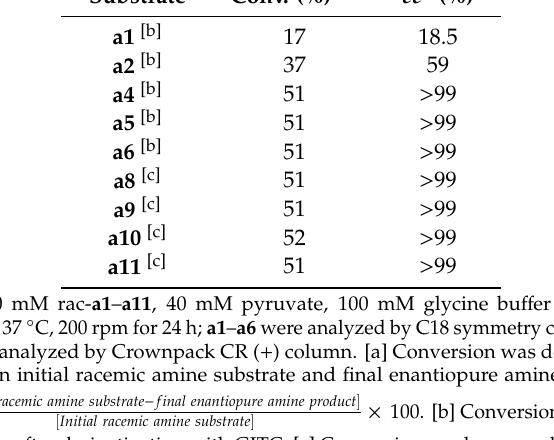
Table 1. Kinetic resolution of various racemic amines .